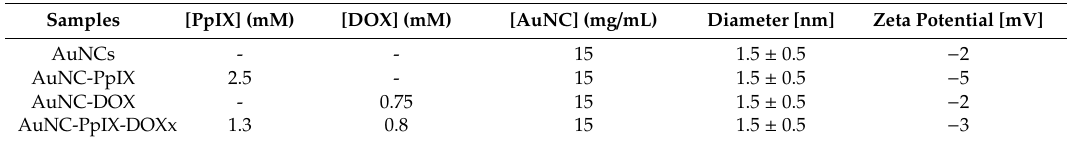
Table 1. Concentration of gold nanoclusters and drugs (Protoporphyrin IX, PpIX, and Doxorubicin, DOX) present in stock solutions and hydrodynamic diameters and zeta potentials of all